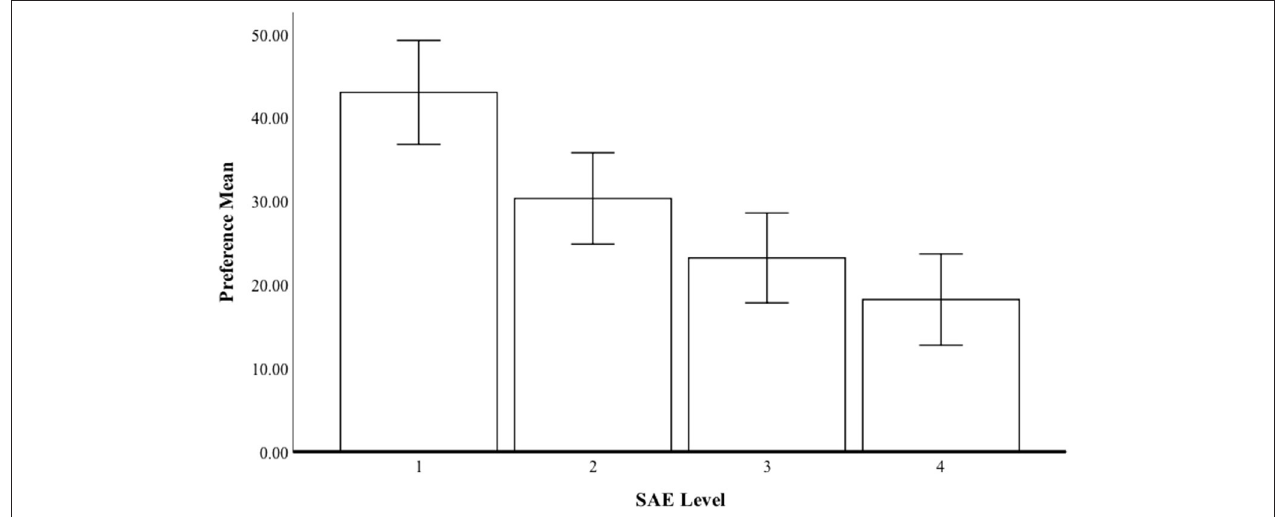
FIGURE 2 | Attitudes to automatization (SAE levels